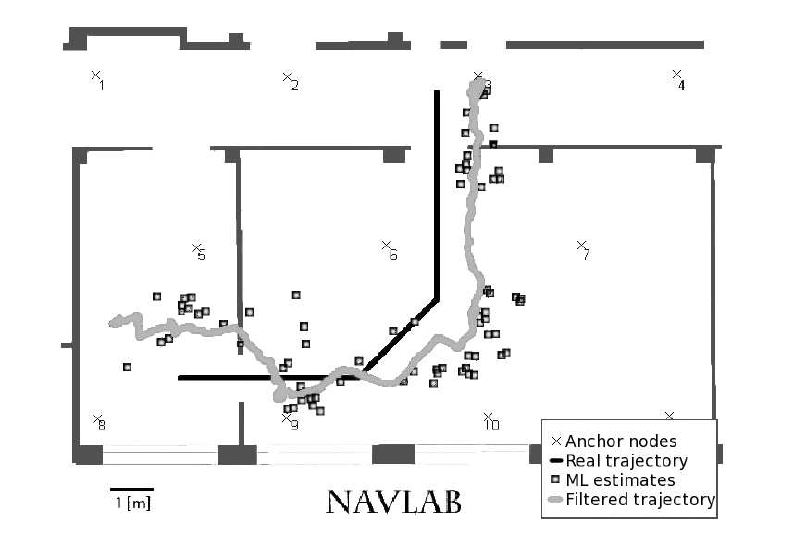
Figure 12. Tracking experiment. The reconstructed path is represented with a light grey solid line, non-filtered measurements are indicated with square markers; the actual path is shown with a solid black line. The sensor nodes of the fixed network are represented with